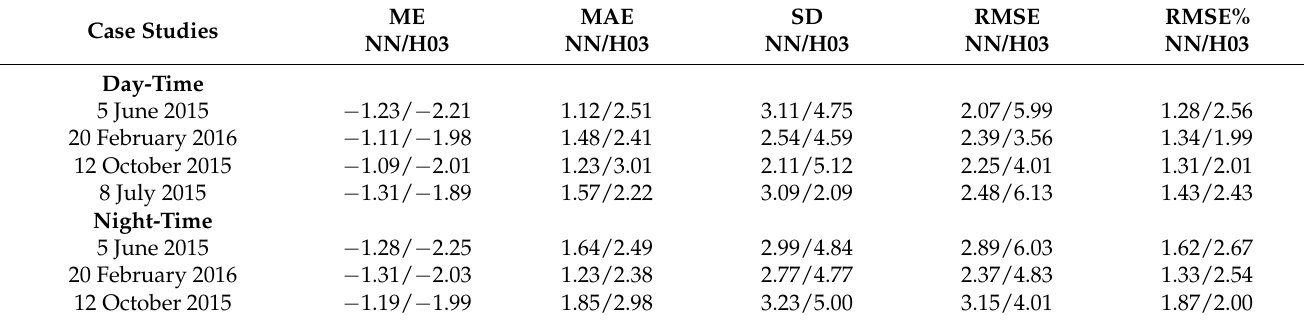
Table 12. Continuous scores for neural network technique (NN) and PR-OBS-3A (H03)